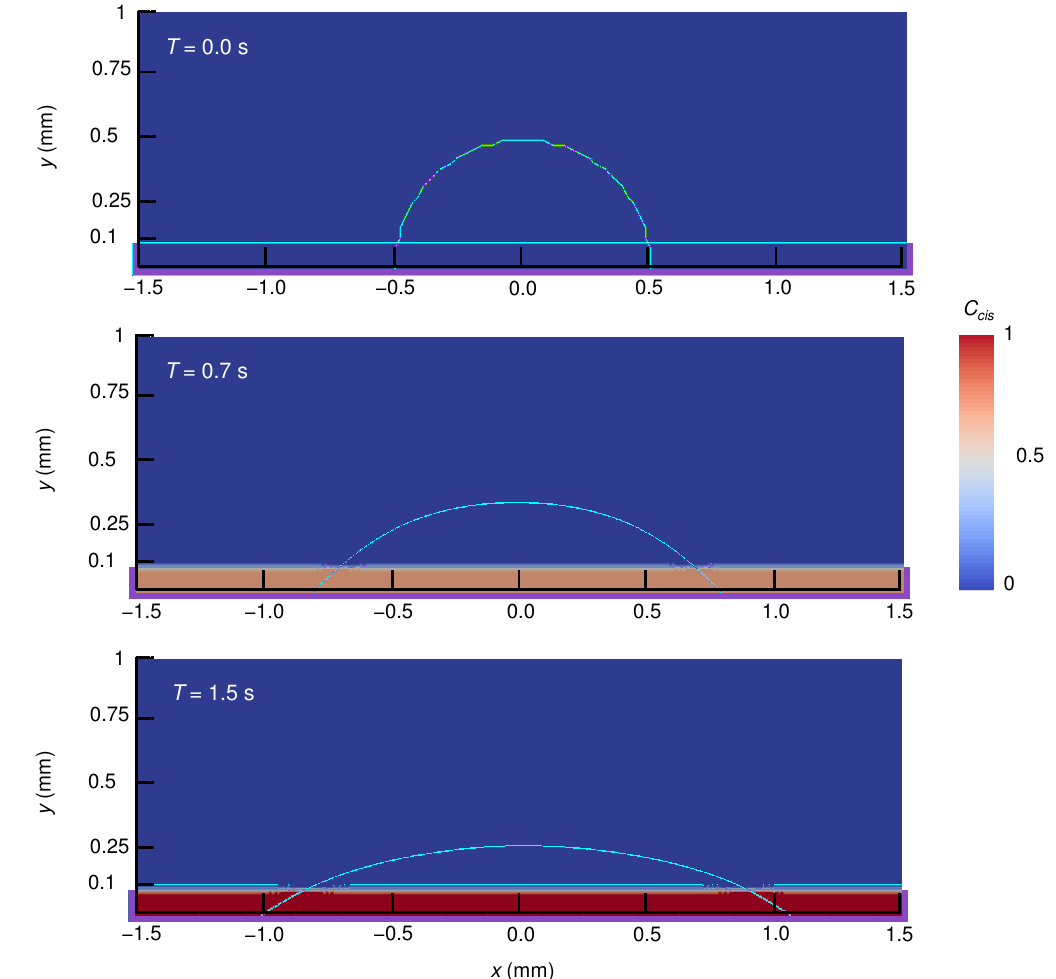
Figure A4. Temporal evolution of a droplet due to the photoisomerization-induced contact-angle change. Contour shows C cis . The contact angles for C cis = 0 and 1 are 30 ◦ and 90 ◦ , respectively. Solid cyan line outlines the droplet shape, and the purple-colored regions represent the UV-light irradiation